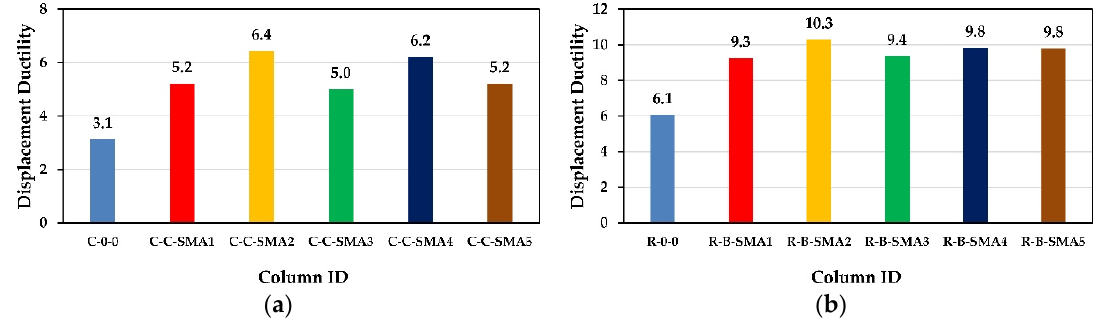
Figure 9. Displacement ductility capacity: ( a ) Columns of Group1; ( b ) columns of Group2.